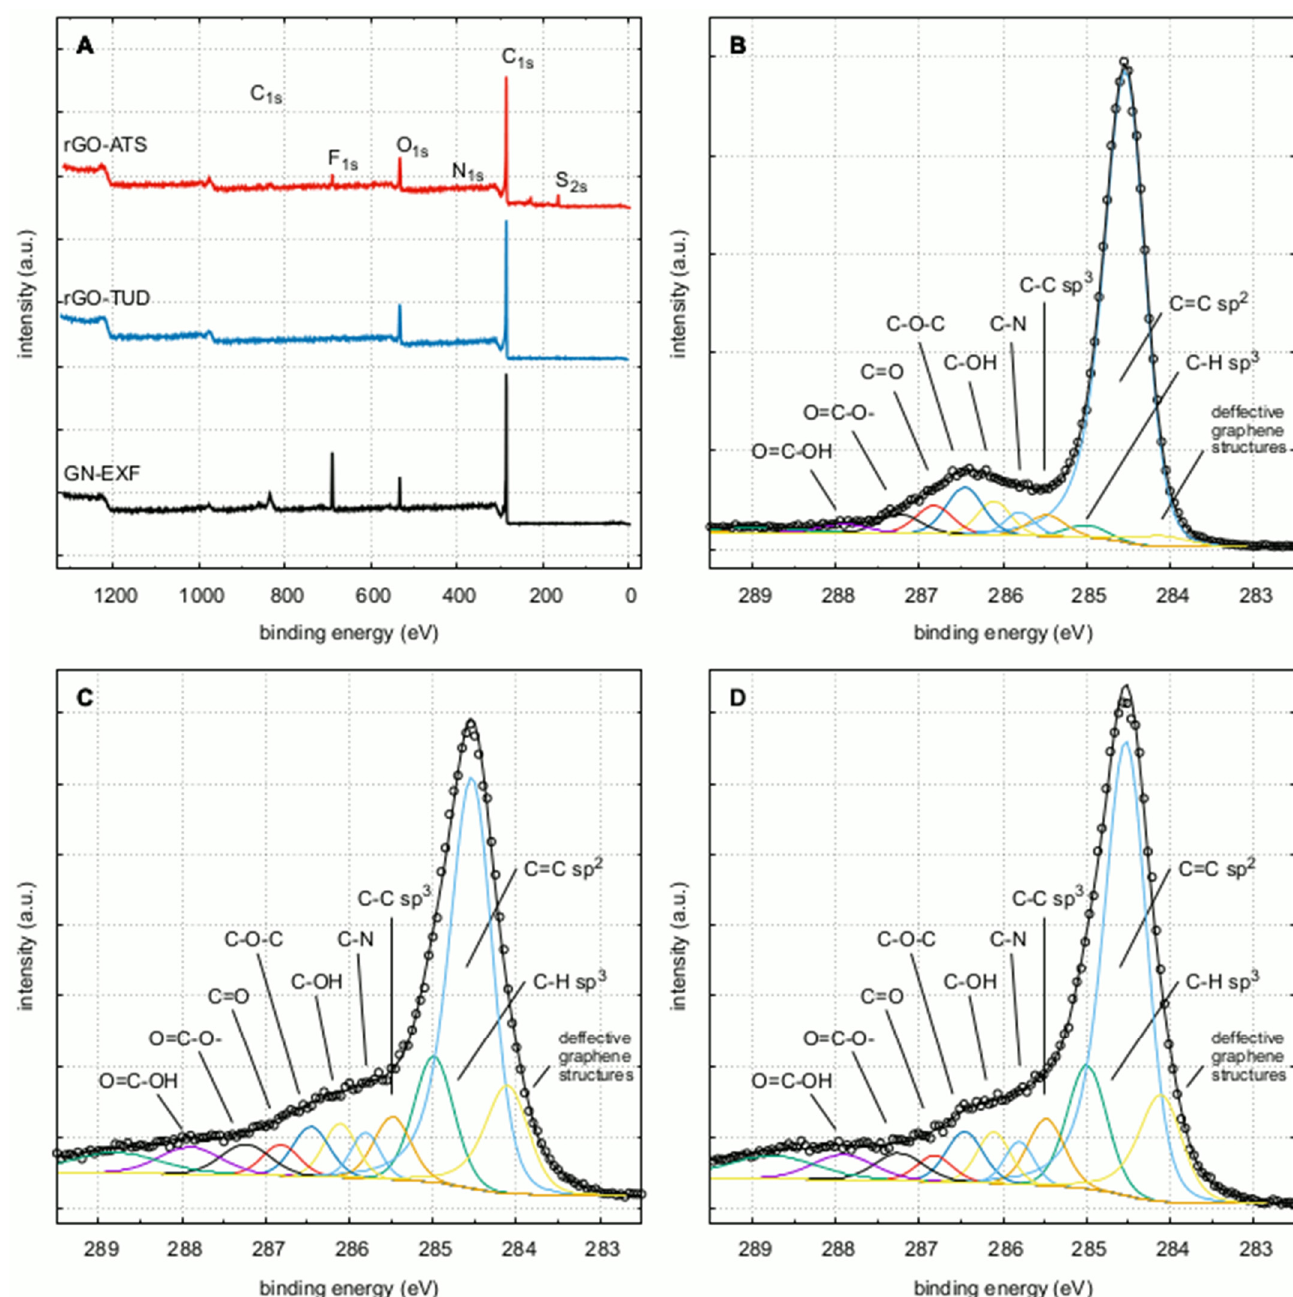
Figure 1. X-ray photoelectron spectroscopy (XPS) results: survey spectra of GN/ExF, rGO/TUD, and rGO/ATS ( A ), C1s high-resolution spectra (HR) of GN-EXF ( B ), rGO-TUD ( C ), and rGO-ATS ( D ). Abbreviations: rGO, reduced graphene oxide; GN, graphene; C, control group (untreated group); ExF, exfoliation; ATS, ammonium thiosulphate; TUD, thiourea dioxide.